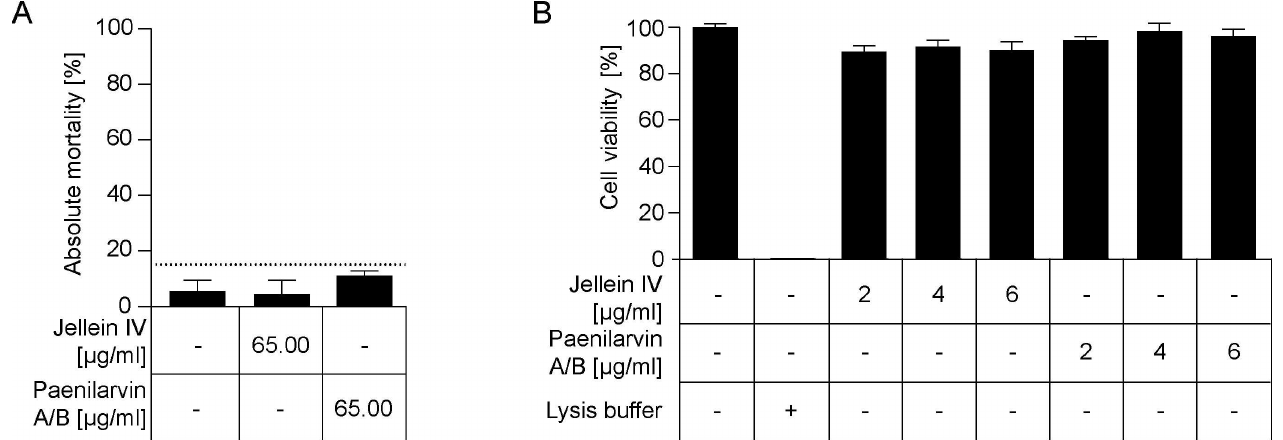
Fig 3. Toxicity of paenilarvins towards larvae and insect cells. (A) Larvae were in vitro -reared on normal larval diet. At day 4 post grafting, the treatment group received larval diet supplemented with 65 μ g/mL paenilarvinA/B. Of the two negative control groups, one received larval diet supplemented 65 μ g/mL jelleinIV and the other received un-supplemented larval diet. Larvae were reared for 14 days and total larval mortality until day 14 is shown. The results are shown as mean values ± SD of three replicateswith 30 larvae each. Larval mortality stayed below15% for all three groups and no statistically significant difference in larval mortality between the control groups and the paenilarvintreatment group could be established (one-way ANOVA, p-value = 0.44). (B) BTI-Tn5B1-4 cells were incubatedfor 48 h in cell culture medium (SF900 II) without supplement or supplemented with different concentrations of jelleinIV as negative control and of paenilarvinA/B isolated from DSM25430wt. Cell lysis buffer was used as positive control. Cell viability was measured quantitatively by MTT test and the results are shown as mean values ± SEM of three replicates. No statistically significant difference in cell viability after incubationwith any paenilarvinA/B concentration compared to the negative controls was evident (one-way ANOVA, p-value =